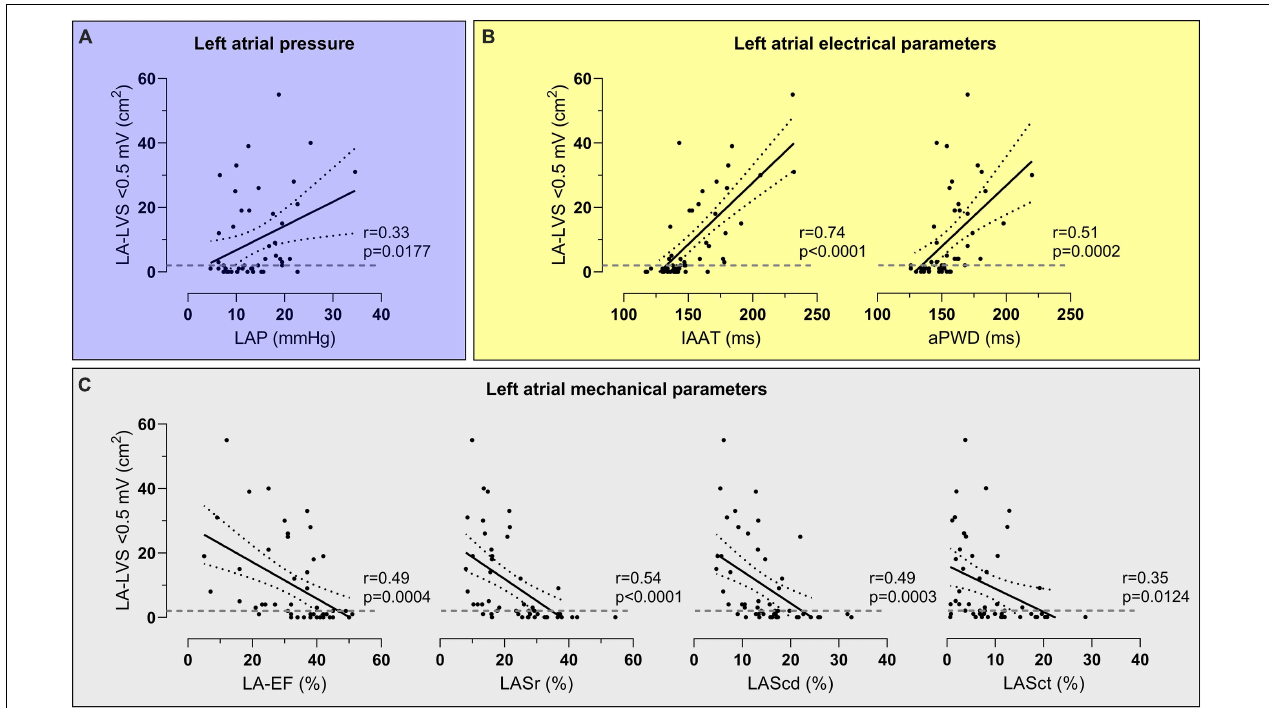
FIGURE 2 | Correlations between atrial cardiomyopathy (ACM) extent and left atrial pressure (LAP), electrical parameters and mechanical parameters. LAP (A) , left atrial electrical parameters [invasive atrial activation time (IAAT), amplified p-wave duration (aPWD), (B) ] and left atrial mechanical parameters [left atrial emptying fraction (LA-EF), left atrial strain during reservoir phase (LASr), conduit phase (LAScd), and contraction phase (LASct), (C) ] correlated significantly with ACM extent [assessed as left atrial area displaying low-voltage substrate (LA-LVS) < 0.5 mV]. The dashed line marks the border between absence ( < 2 cm 2 LA-LVS extent at 0.5 mV threshold) and presence of relevant